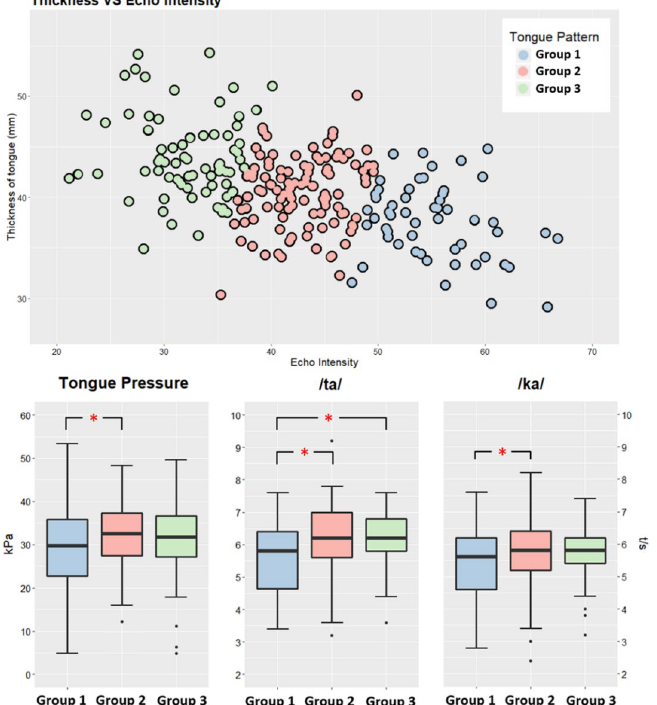
Figure 4. Scatter plot of echo intensity and tongue thickness using the K-means for the three groups. Box plot comparison of tongue function (tongue pressure, /ta/, and /ka/) among the groups based on tongue characteristics. Tongue pressure: Group 1 vs. Group 2, P = 0.023 (* p value < 0.05). /ta/: Group 1 vs. Group 3, P = 0.001 (* p value < 0.05); Group 1 vs. Group 2, P = 0.007 (* p value < 0.05). /ka/: Group 1 vs. Group 2, P = 0.038 (* p value < 0.05).